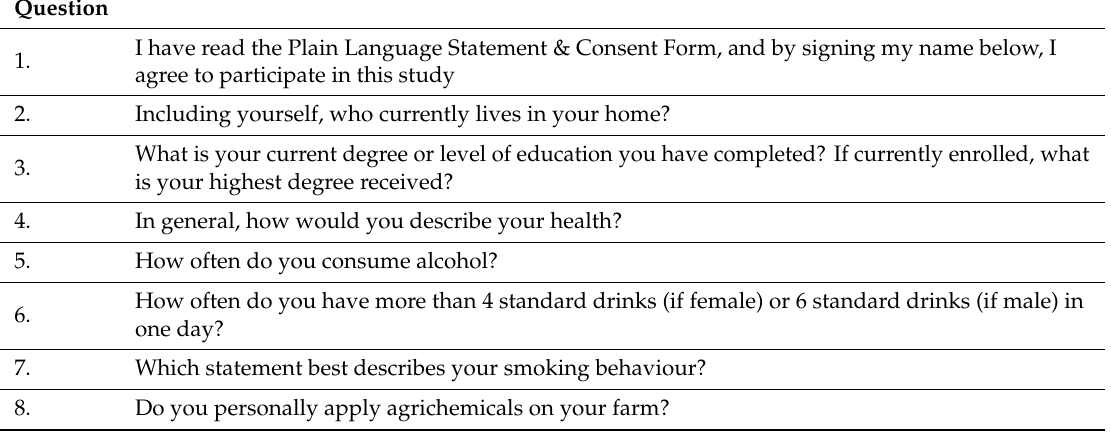
Table A1. Chemical usage Survey questions applied pre and post participation in the In-field Personalised Cholinesterase Assessment Project